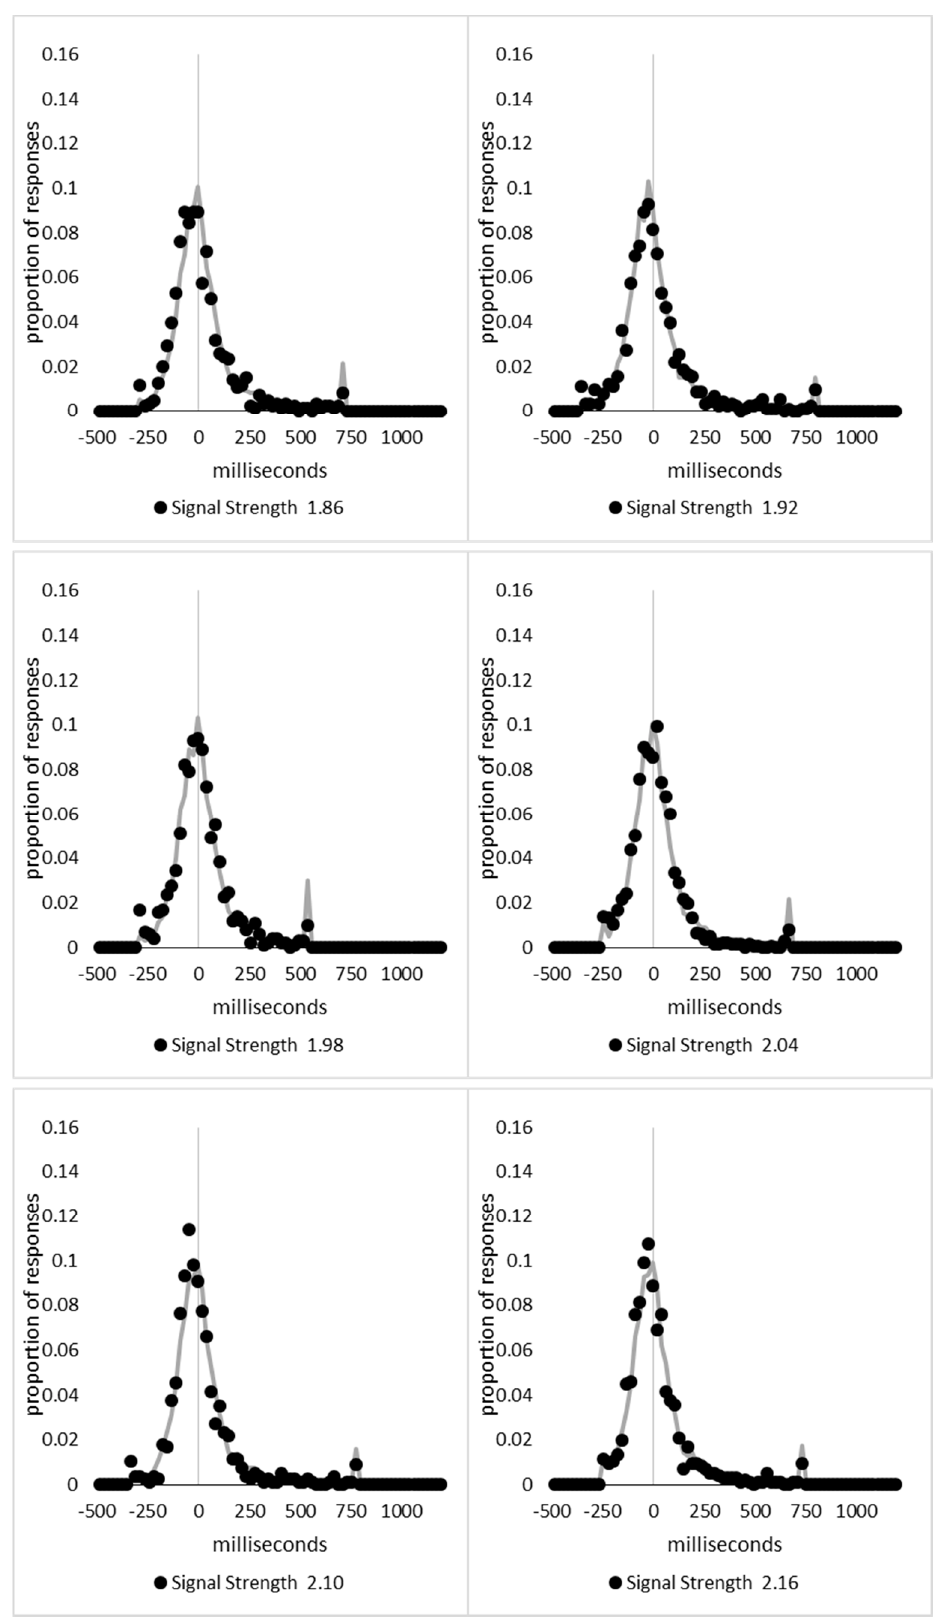
Figure A6. Density functions of the observed data (filled circles) and model (solid line) for signal strength bins 1.86 to 2.16.